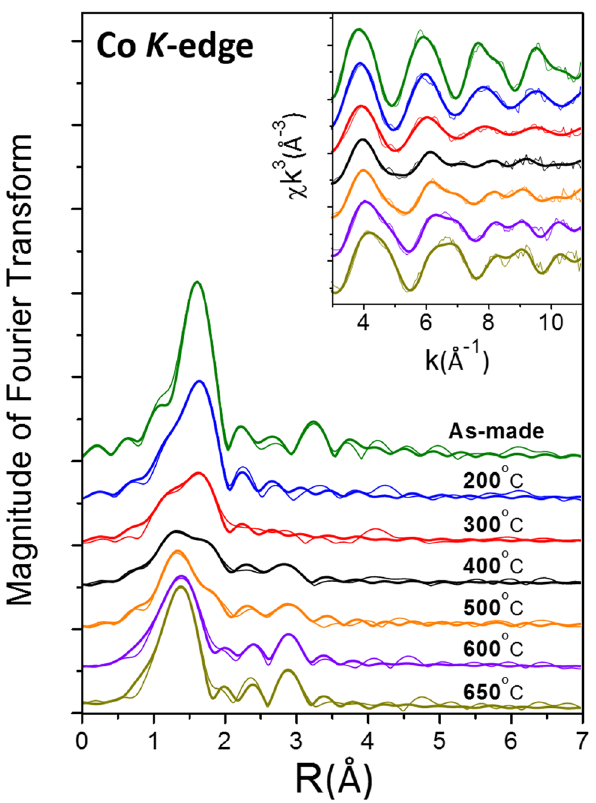
Figure 4. Co K-edge EXAFS data for Co-doped CeO 2 samples. Fine lines: experimental; Coarse lines: curve fitting. Curves have been shifted vertically for the sake of